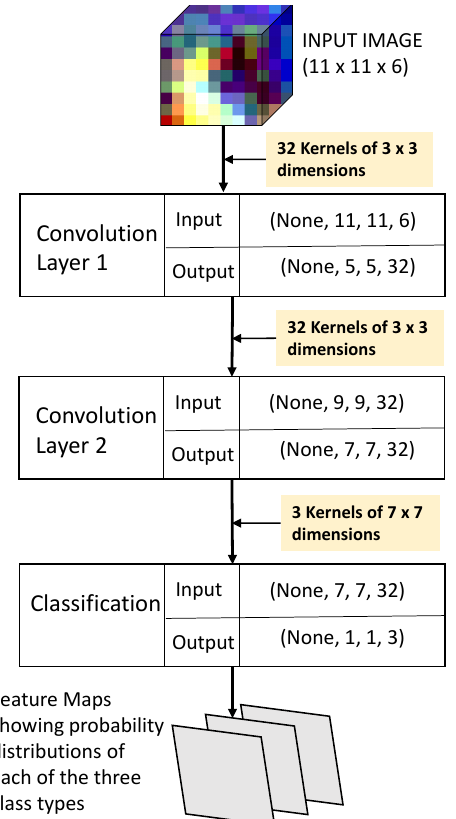
Figure 6. Overview of the process flow for an architecture with (L1,L2) = (32,32) trained with N-11. Filters and feature maps are shown as well as input and output data sizes at each